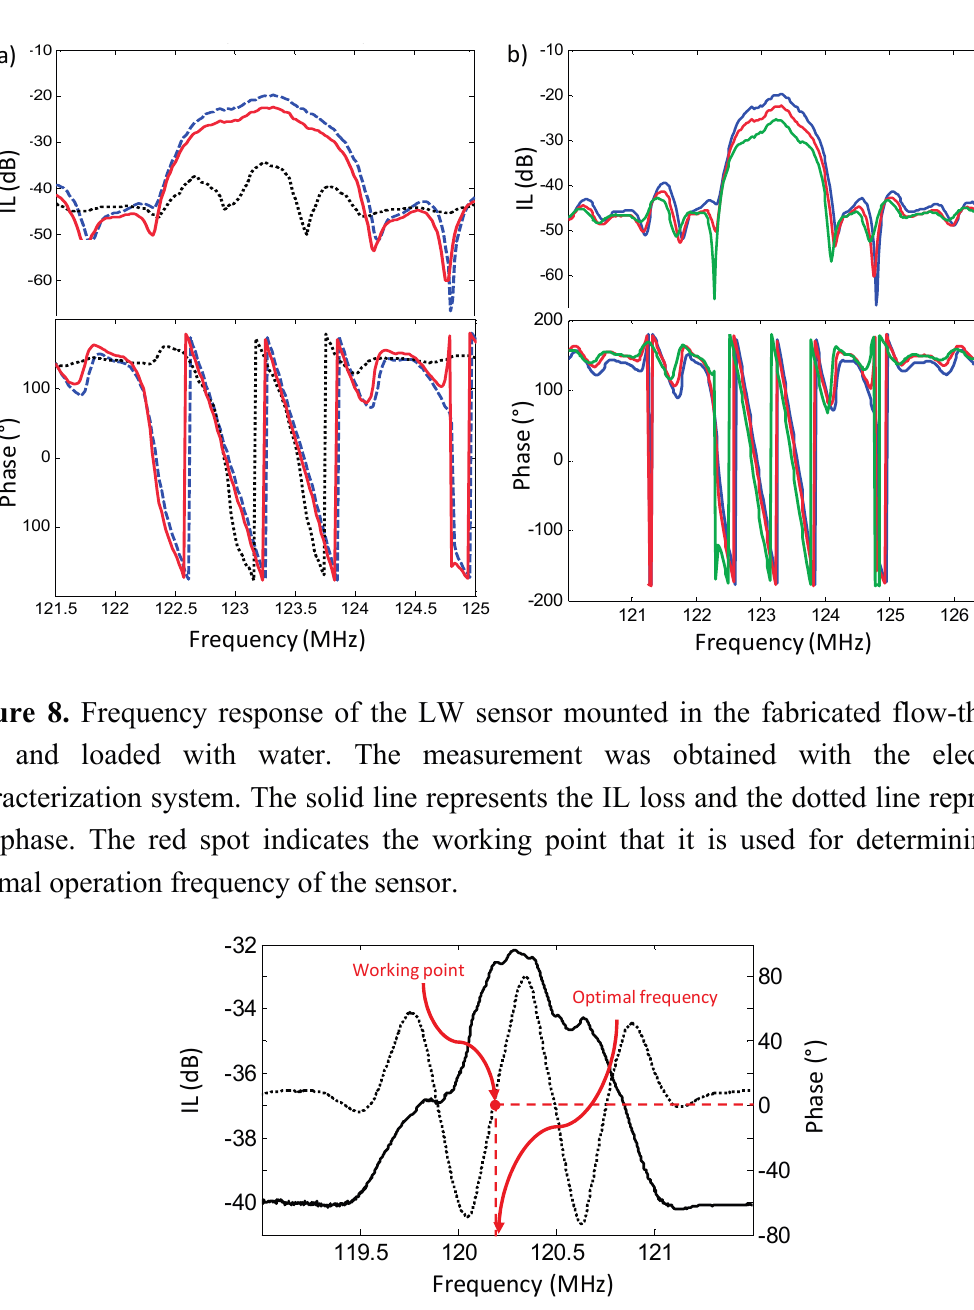
phase was linear around the working point. Thus, the fabricated flow-through cell allowed an effective operation of the LW sensors in contact with liquid media. Figure 7. Comparison between different frequency responses of the same fabricated LW sensor mounted in the flow-through cell. The measurements were obtained using a Network Analyzer. The insertion loss and the phase have been depicted in the upper and lower part of the figures, respectively. ( a ) Sensor in contact with air. The dotted, solid, and dashed responses were obtained with the flat-end seal, the peak-end seal and no seal on the sensing area, respectively; ( b ) Blue solid line represents the sensor response with no central seal; red solid line with the central peak-end seal; and green solid line with the peak-end seal and a double distilled water load.